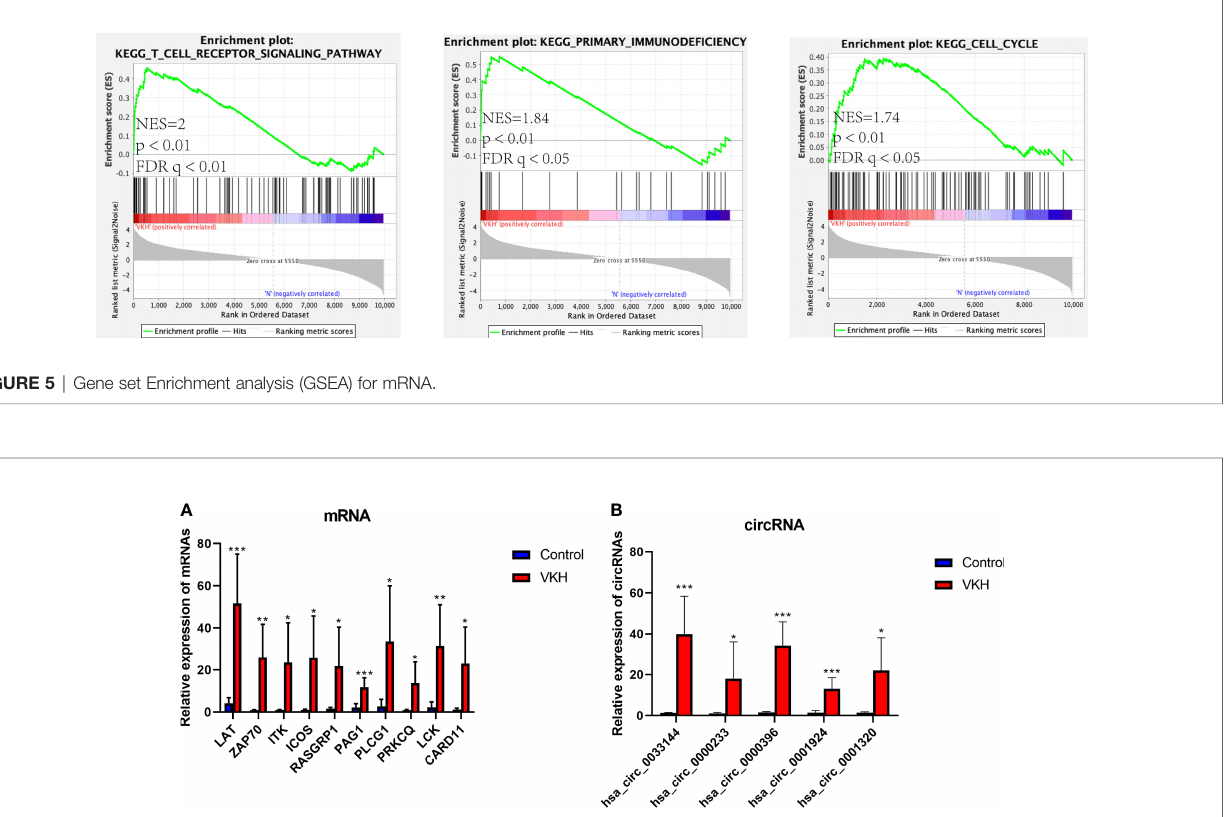
FIGURE 6 | Validation of differentially expressed mRNAs and circRNAs in VKH group and control group. (A) The expression levels of 10 mRNAs detected by RT- qPCR of 6 VKH patients and 6 healthy controls. (B) The expression levels of 5 circRNAs detected by RT-qPCR in CD4 + T cells of 6 VKH patients and 6 healthy controls. The data are presented as the mean±SD. *P < 0.05; **P < 0.01; ***P <